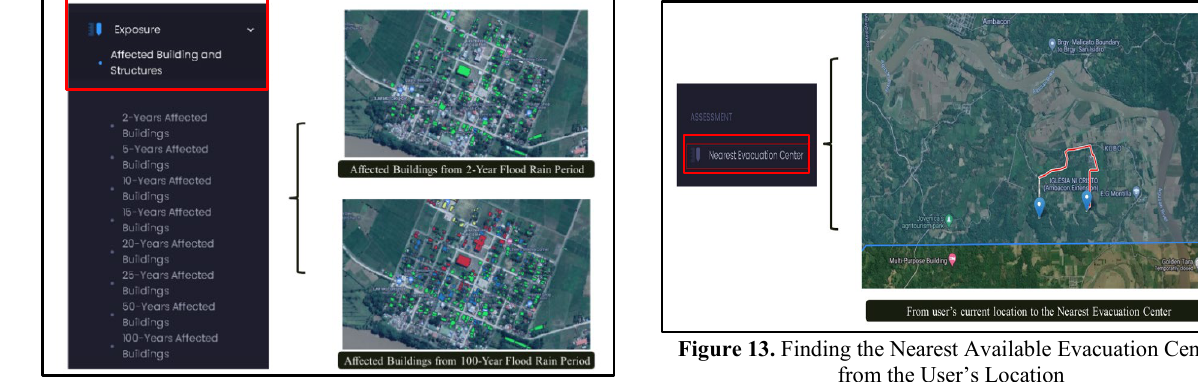
Figure 11. 2-Year and 100-Year Flood Rain Periods from Flood Events under Display Options